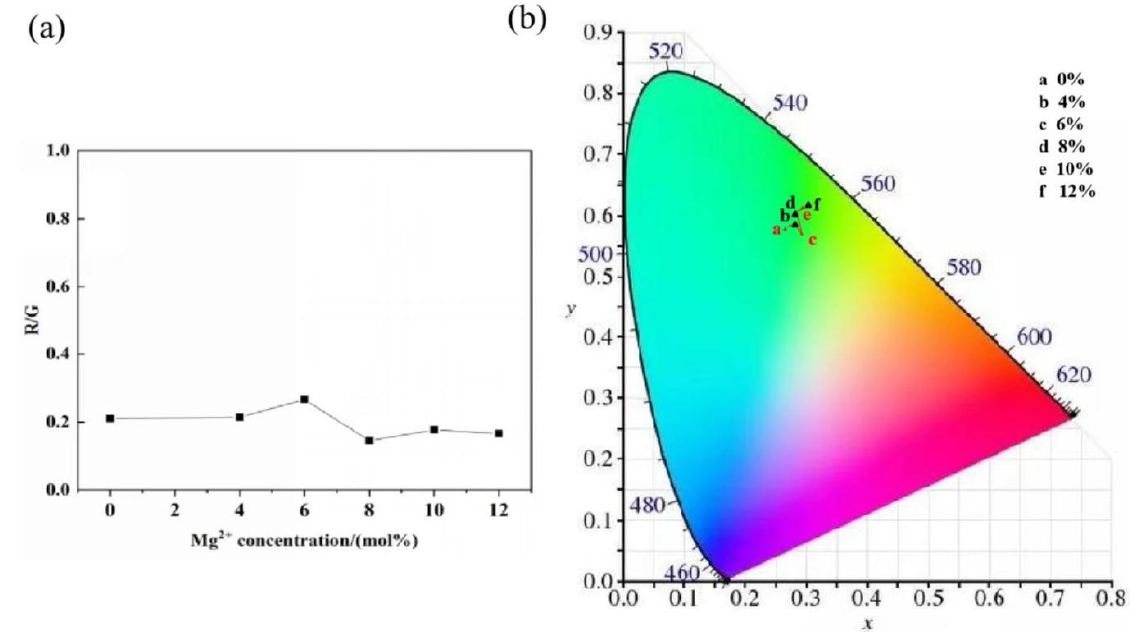
Figure 5. ( a ) Upconversion red–green light intensity ratio of Mg 2+ -doped LiYF 4 :Yb 3+ /Ho 3+ UCMPs; ( b ) CIE of Mg 2+ -doped LiYF 4 :Yb 3+ /Ho 3+ UCMPs.